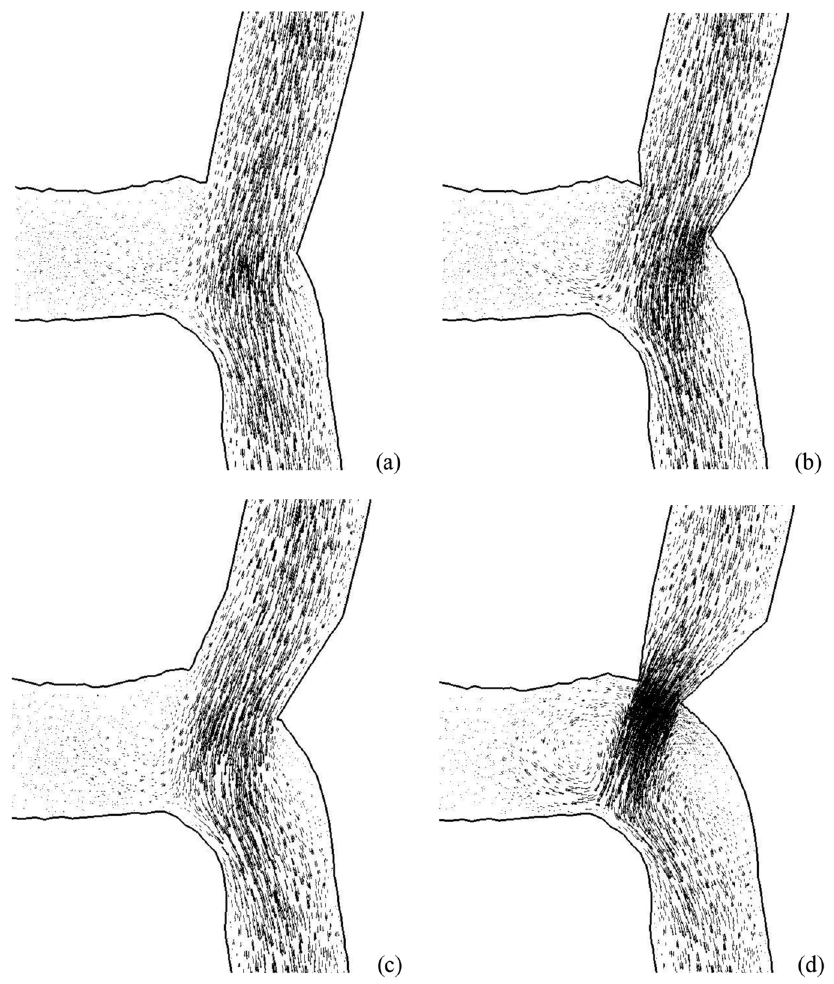
Figure 6. The distribution of time-averaged (over a cardiac cycle) flow velocity (Unit: cm/s) at the anastomosis between SVG and coronary artery in correspondence with Fig. 4.